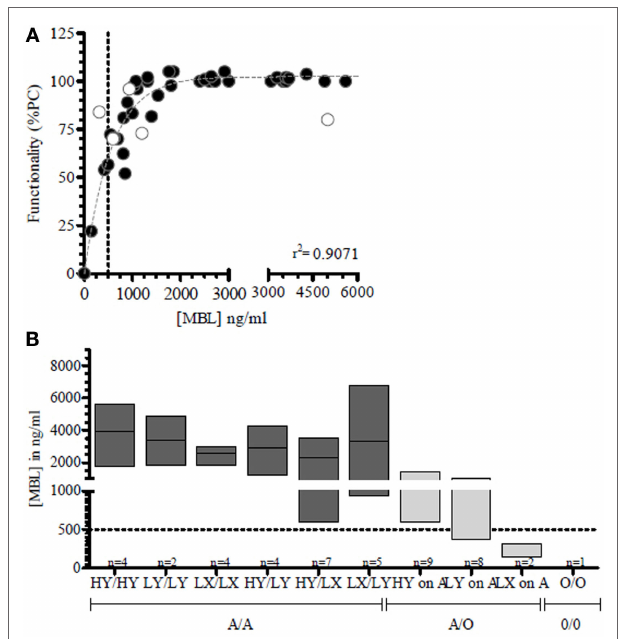
FigUre 3 | classical (cP) and alternative (aP) pathway complement activity at all time points in all patients of the c2012 study . (a) In 13.5% of the time points showed a reduced functionality of the CP, and in 18.9% a reduced AP activity was observed. (B) Reduced functionality of the CP was divided into specific pathway inhibition ( n = 31; 4.6%) or coincided with reduced AP activity ( n = 60; 8.8%). Specific AP defects accounted for 11.5% ( n = 75). The dotted line depicts the lower limit of functionality in controls, as defined by Seelen et al. (22) for CP functionality (abnormal < 75%) and AP functionality ( < 40%) in the WIELISA assay. Functionality is depicted as percentage of a positive control (%PC).